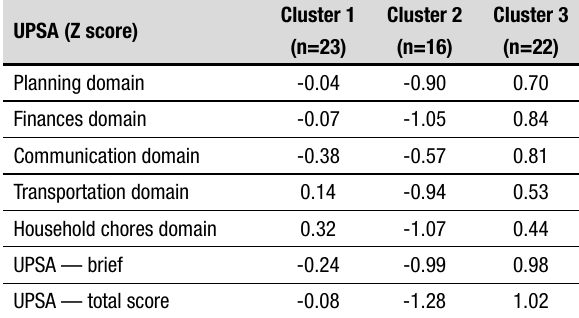
Table 2. Clusters’ final centers.